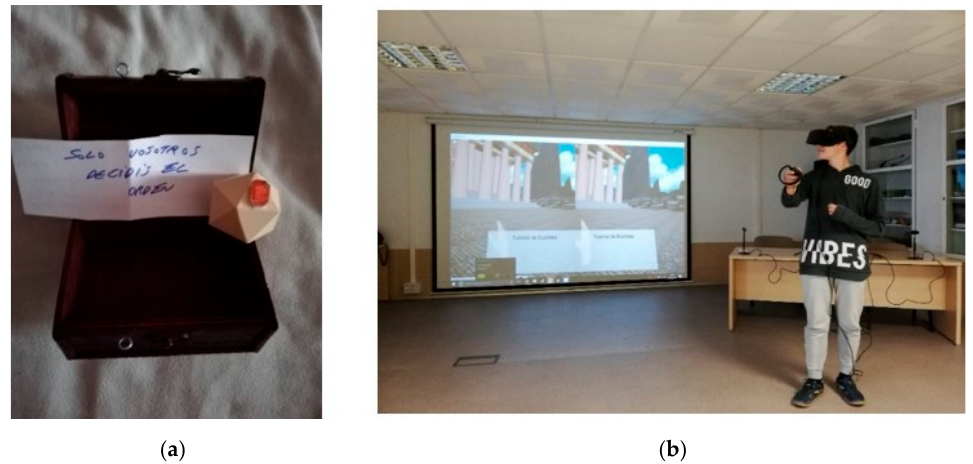
Figure 15. ( a ) students solving challenges with smartphones; ( b ) clue with QR code in Box 2.